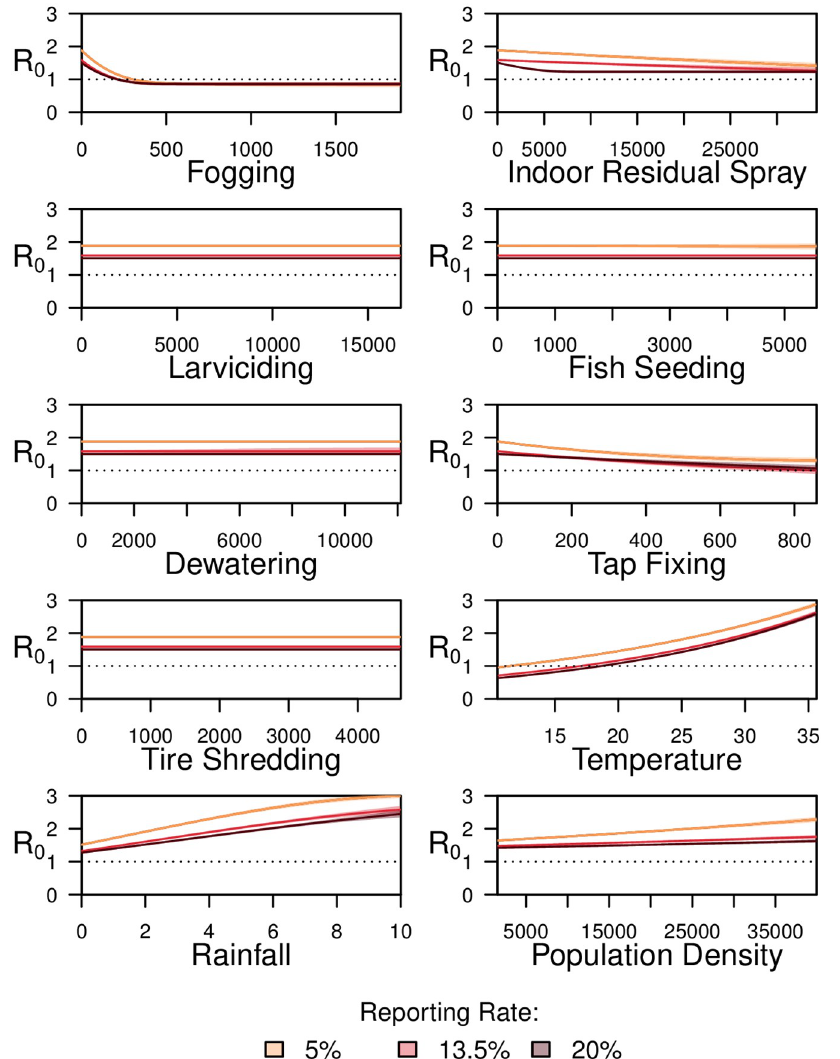
Fig 4. Variation in reproductive number ( R 0 ) of dengue, with variation in parameters, in Lahore. Variation in reproductive number ( R 0 ) of dengue, with variation in parameters, in Lahore during 2012–2017 for different incidence reporting rate values. For containment activities, x-axis represents the total number of containment activities performed, in a spatial unit, in a lagged time step and any residue from previous weeks. For temperature, x-axis represents the average temperature in Celsius in a lagged time step. For rainfall, x-axis represents the number of rainfall days in a lagged time step. For population density, x-axis represents individuals per 1 sq.km.